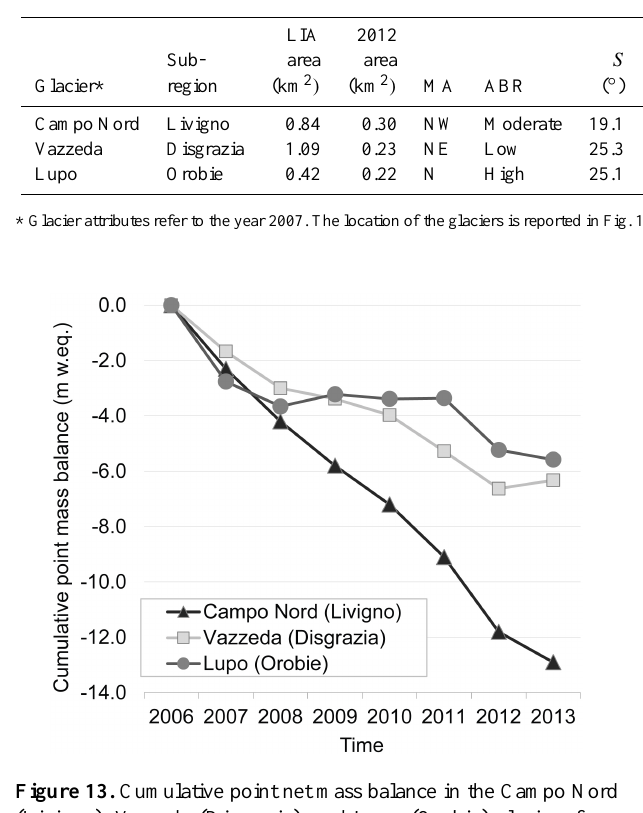
Figure 12. Histogram showing winter, summer, and net point mass balance at (a) Campo Nord glacier (Livigno), (b) Vazzeda glacier (Disgrazia), and (c) Lupo glacier (Orobie) from 2007 to 2013. Point mass balance data are measured with two ablation stakes placed across the ELA 0 of each glacier (see Table 5 for further details). Table 5. Topo-climatic attributes of the glaciers selected for interannual mass balance analysis.